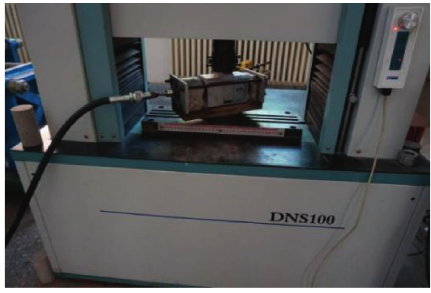
Figure 7: Two-sided shearing